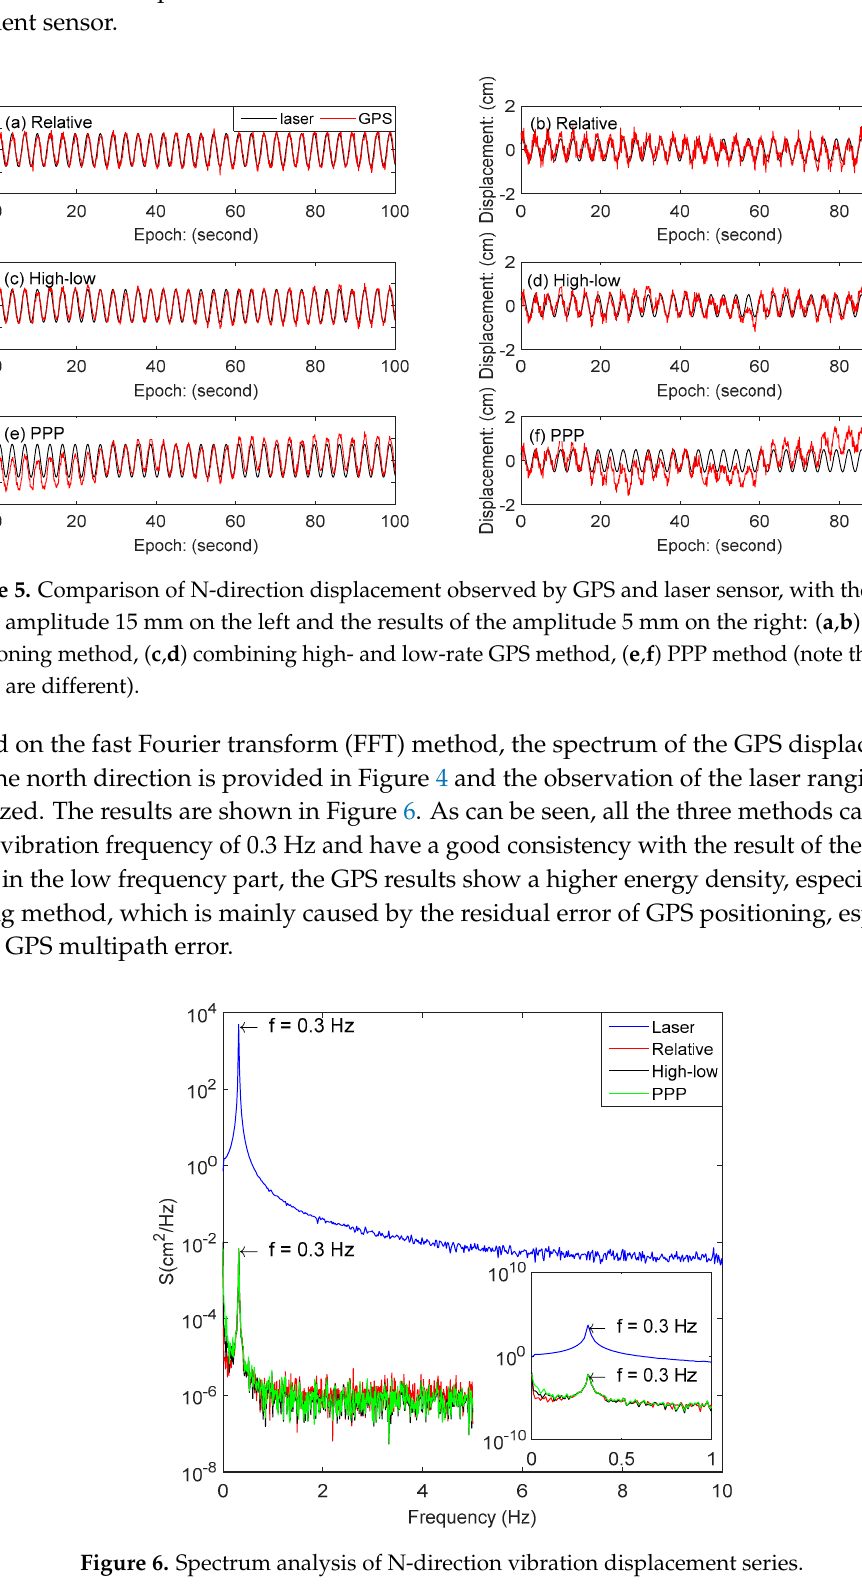
Figure 6. Spectrum analysis of N-direction vibration displacement series.